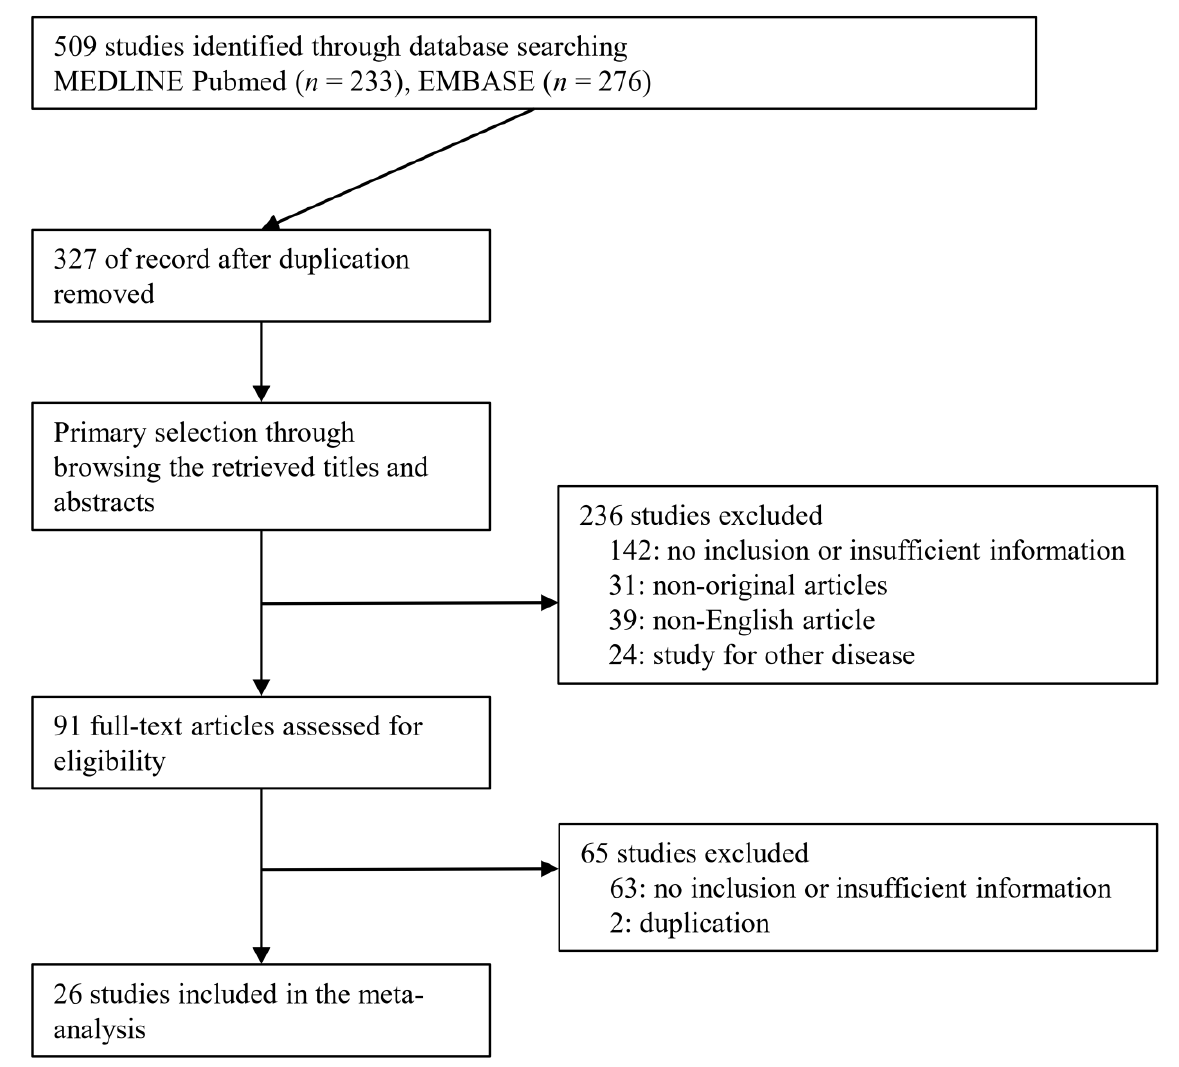
Figure 1. Flowchart summarizes literature and study selection.